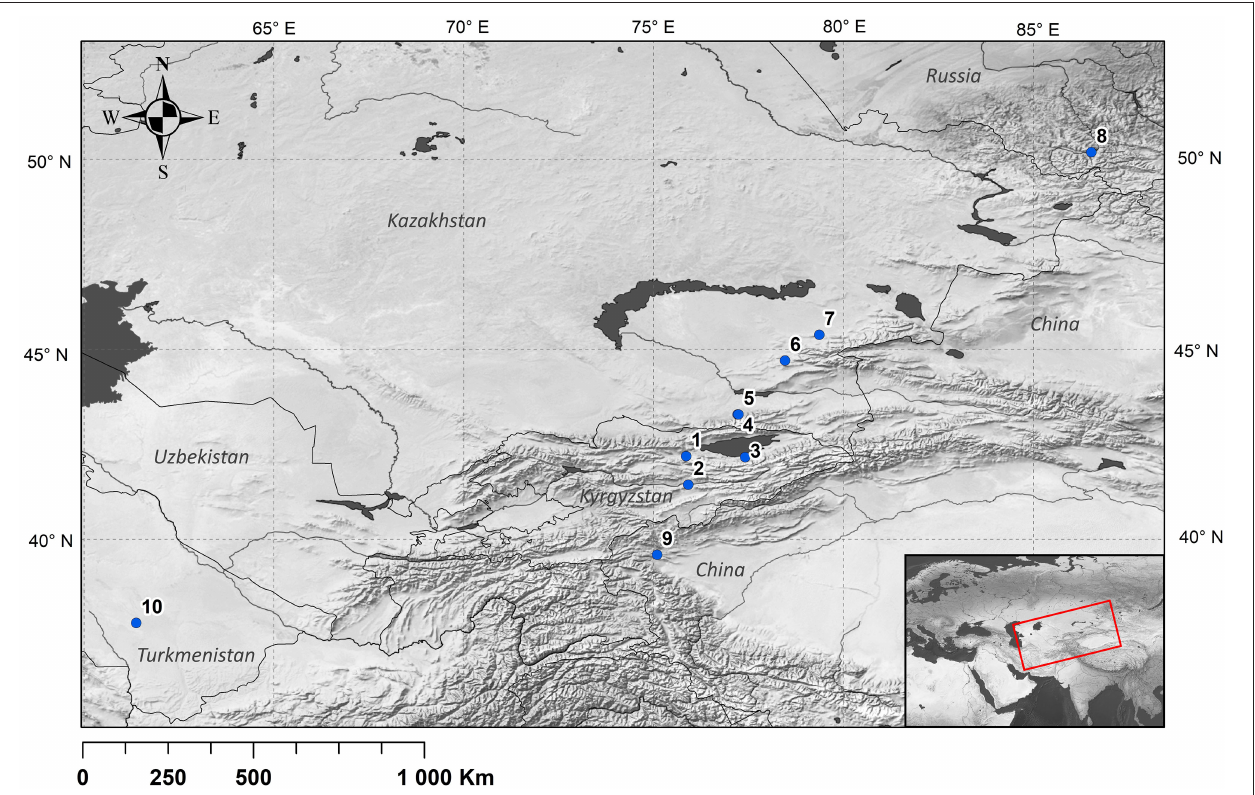
FIGURE 1 | Archaeological sites mentioned in the paper: 1, Chap; 2, Aigyrzhal; 3, Uch-Kurbu; 4, Tuzusai; 5, Tseganka; 6, Begash; 7, Tasbas; 8, Tongtian cave; 9, Wupaer; 10, Adji-Kui.